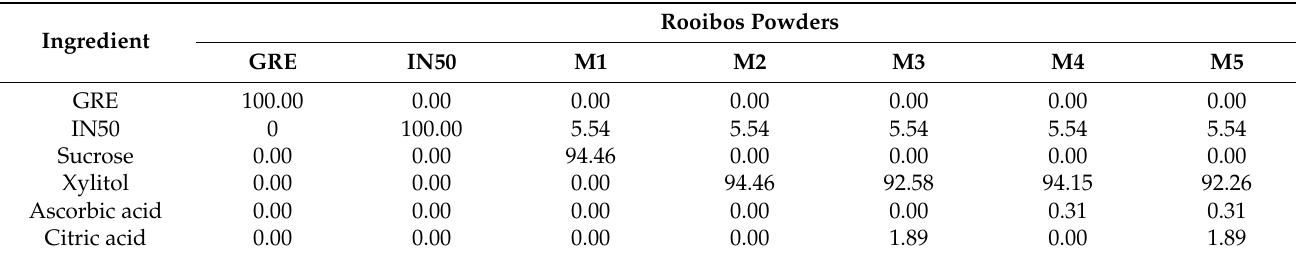
Table 5. Components (%) of green rooibos extract powder and powder mixtures containing GRE 1 or IN50 2 as the nutraceutical ingredient and various food grade ingredients including sugar or xylitol and